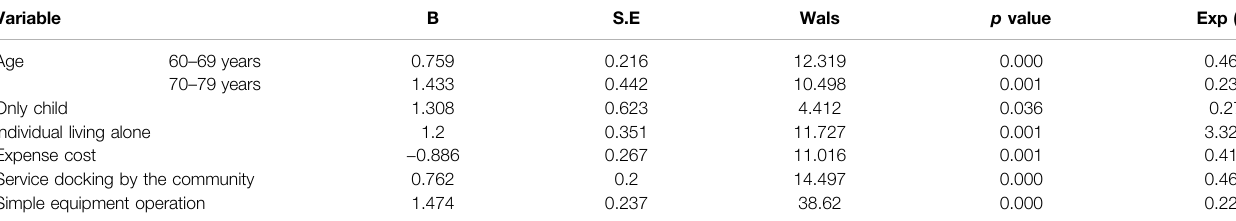
TABLE 9 | Logistic regression analysis results of factors in fl uencing the adoption behavior of smart elderly service users. Variable B S.E